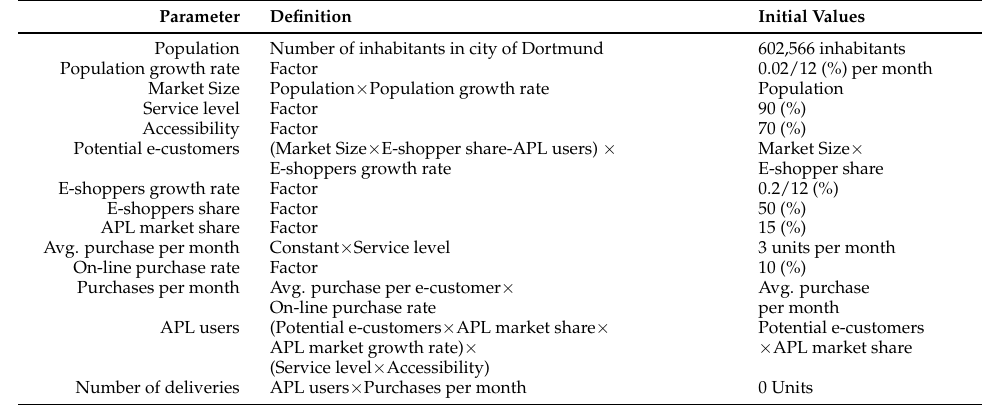
Table 1. List and characteristics of variables used on the SDSM of the APL systems